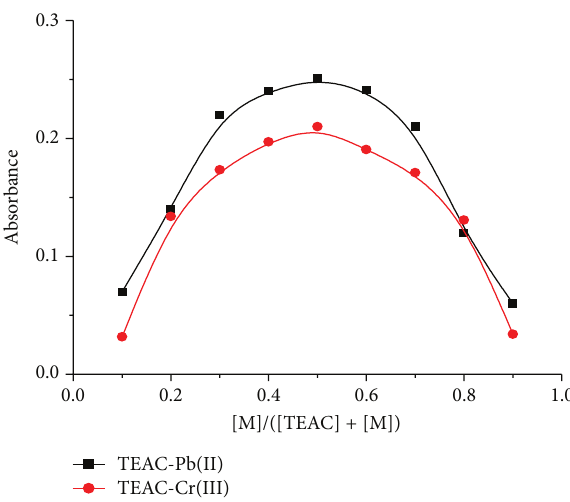
Figure5:Thechangeinabsorbanceonratioof[M]/([TEAC]+[M]) for TEAC-Pb(II) and TEAC-Cr(III) complexes.